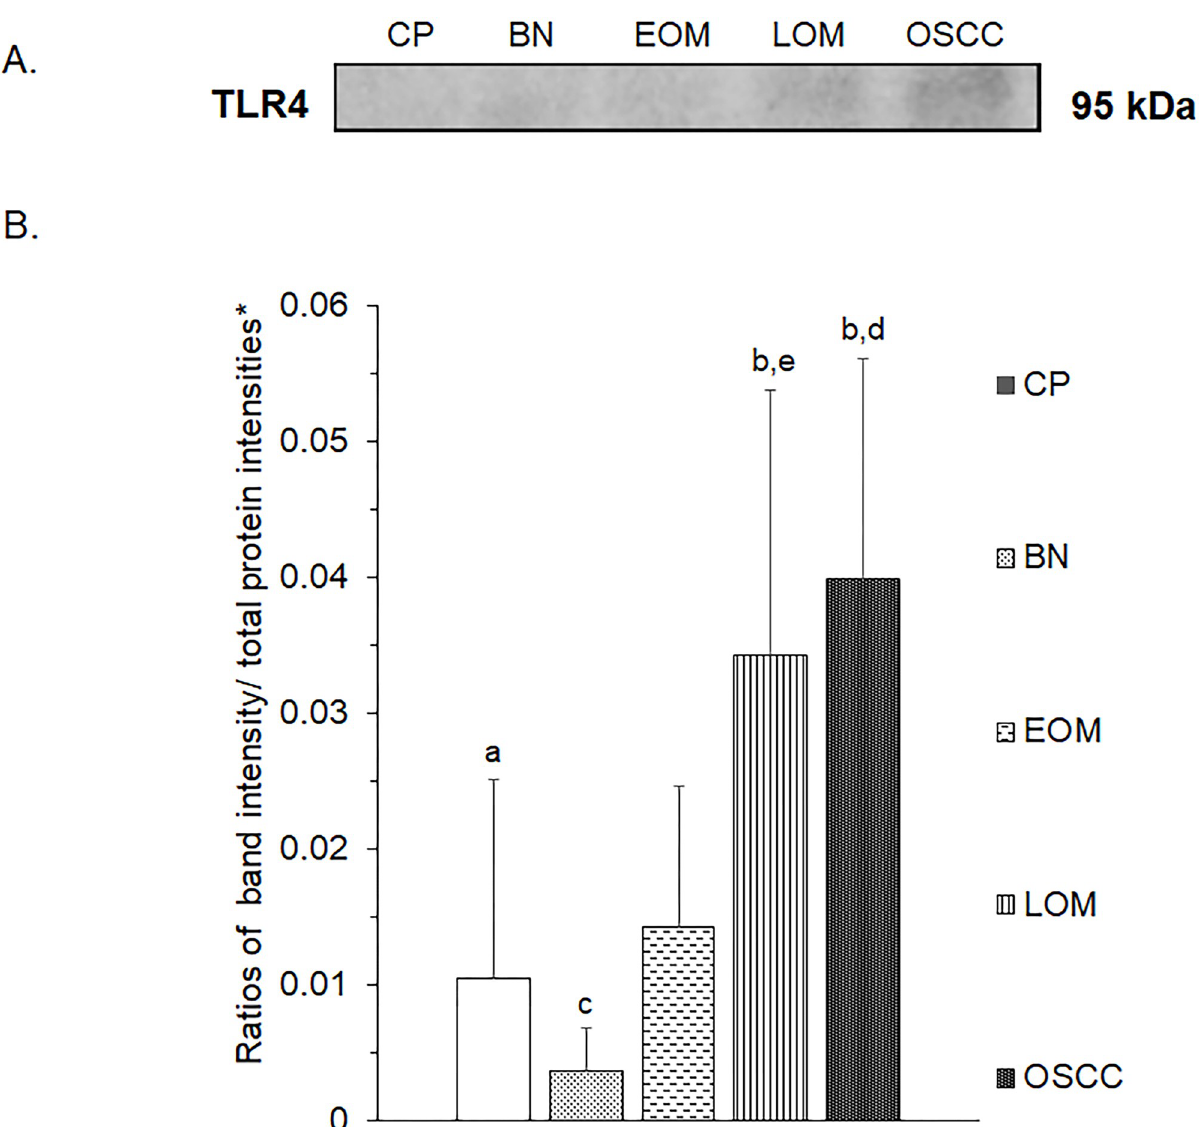
Fig 9. Western blot analysis of salivary toll like receptor 4 (TLR4) of pooled saliva samples from dogs with benign oral tumors (BN), early- and late-stage oral melanoma (EOM and LOM, respectively), oral squamous cell carcinoma (OSCC) and periodontitis and normal controls (CP). Representative western blot for TLR4 at 95 kDa (A) and bar graph of ratios of TLR4 protein intensity to total blotted proteins in each lane in the first half of a membrane � (B) . a–b denote a significant difference at p < 0.05. c–d denote a significant difference at p <